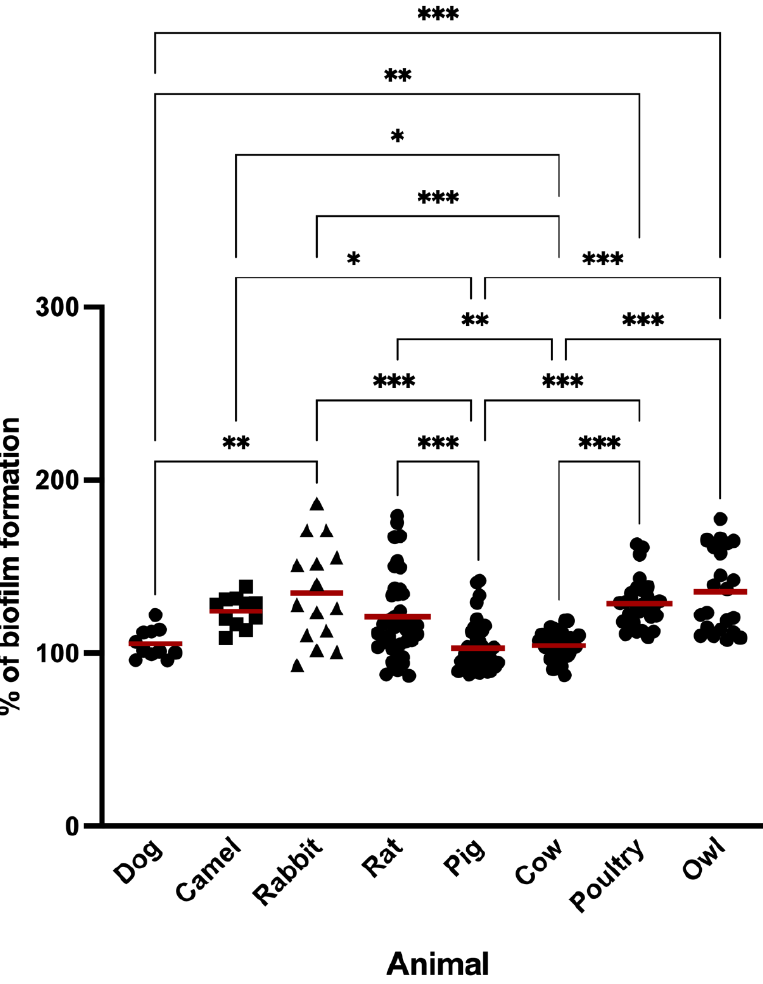
Figure 1. Biofilm formation capacity of S. aureus strains isolated from different animal species. The symbols represent the biomass mean of the biofilm formed in independent tests of the individual isolates. The red lines represent the average of biofilm mass formed by all isolates. Statistical significance was determined using Tukey’s multiple comparison test (* p < 0.05; ** p < 0.01; *** p < 0.001).